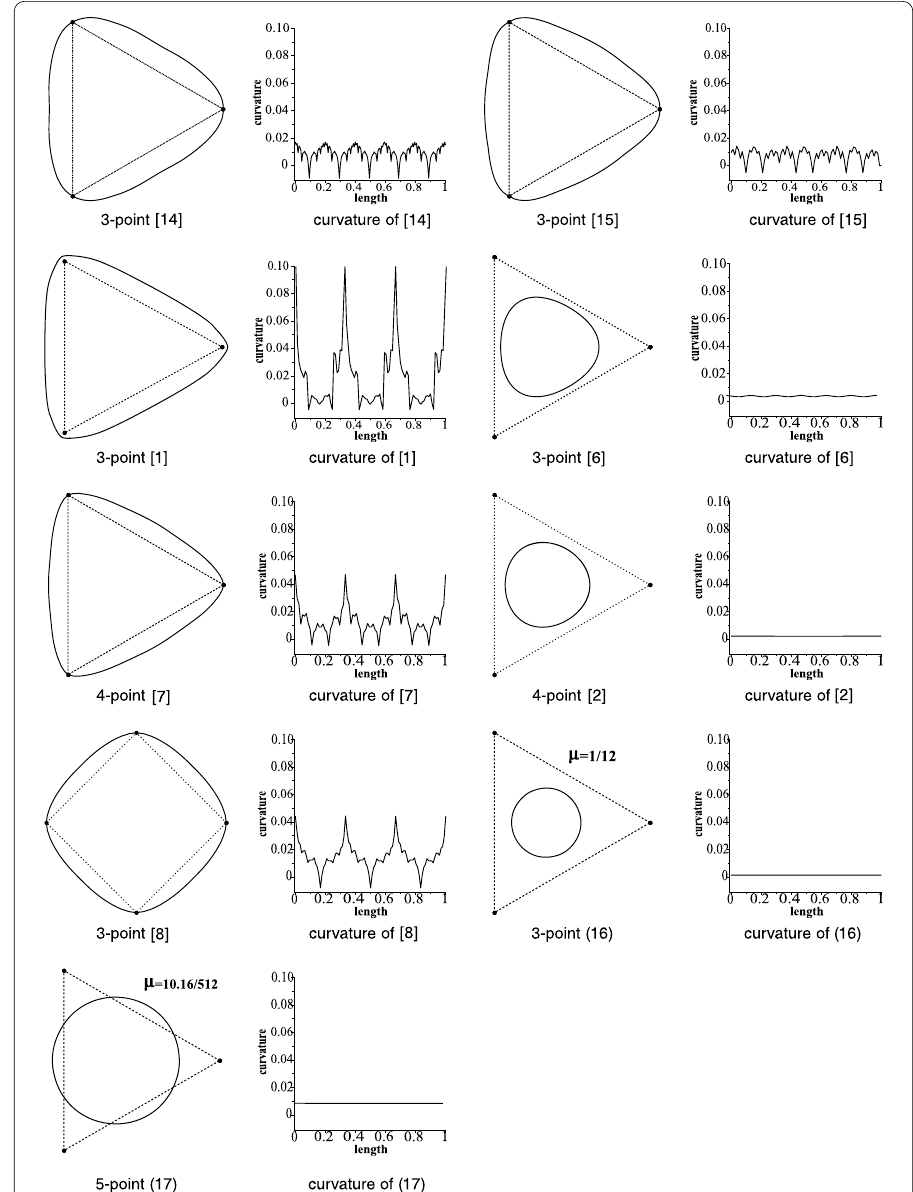
Figure 4 Comparison of existing and proposed SS when three control points are sampled from circle. Left: Limit curves obtained after the 5th iteration, the corresponding curvature is shown in the right column,